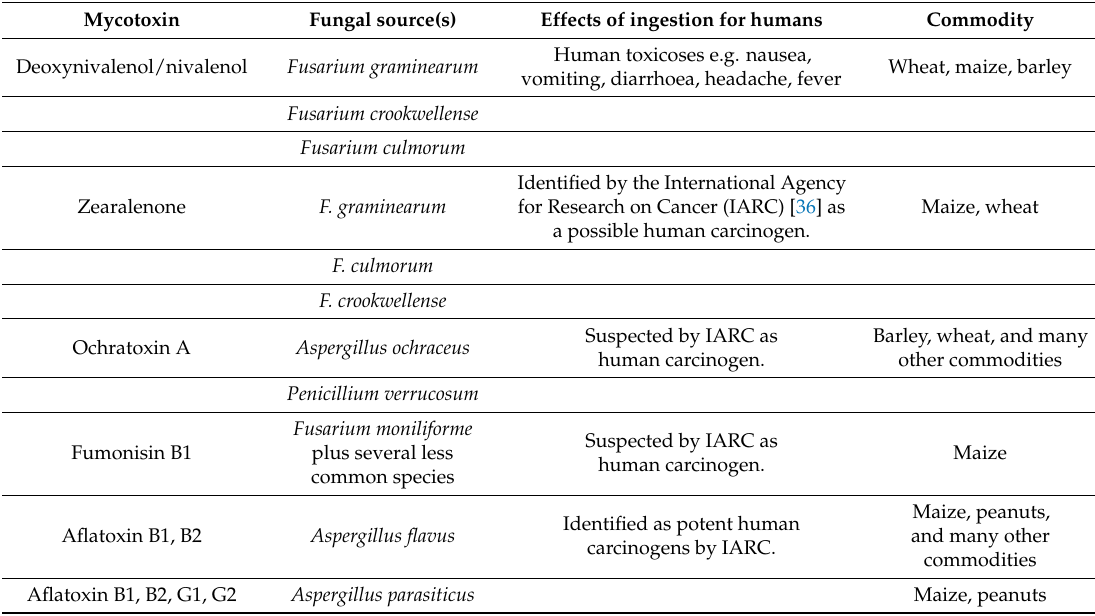
Table 1. Mycotoxins in staple grains and